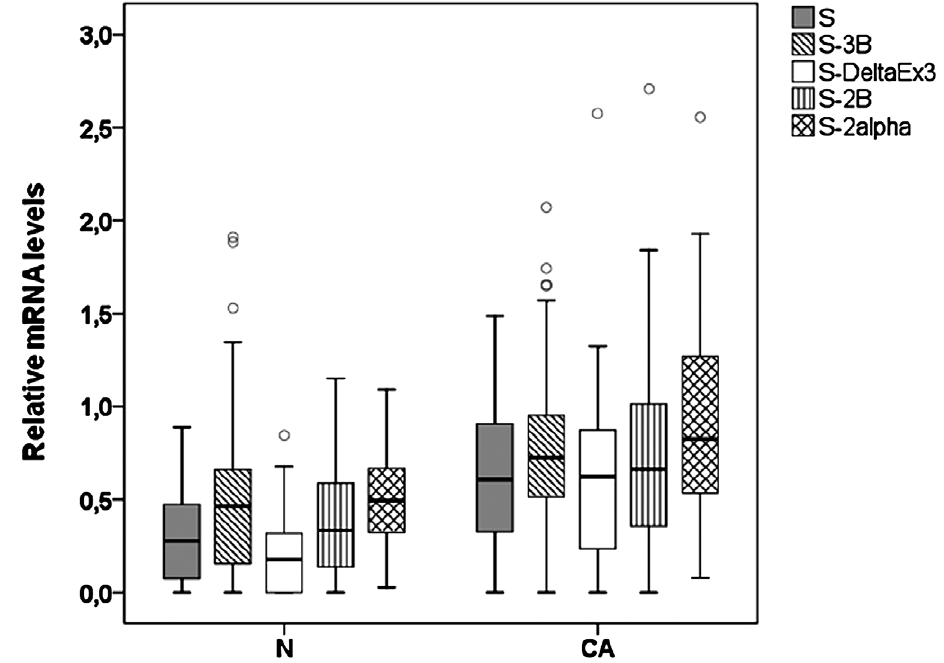
Fig. 2. Expression of survivin splice variants in normal and neoplastic tissue. N – normal tissue, CA – neoplastic tissue, S –